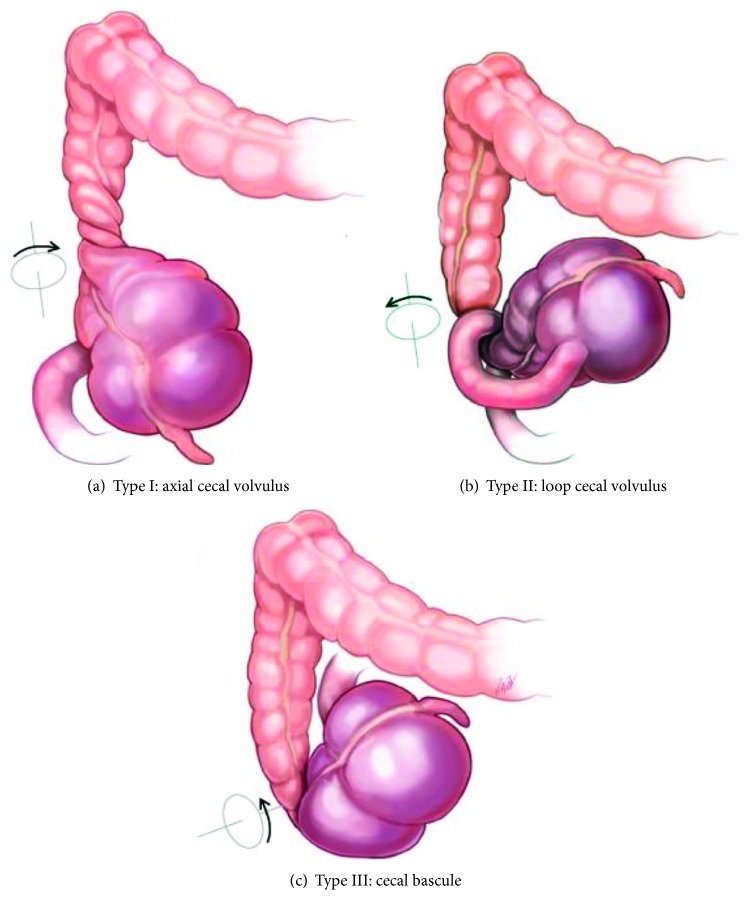
Types of cecal volvulus [2].